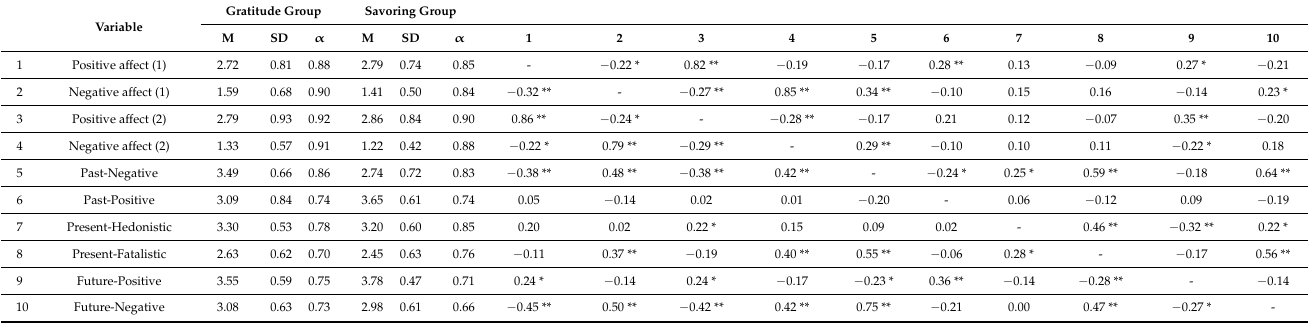
Table A1. Means, standard deviations, Cronbach’s alpha, and intercorrelations between variables in the gratitude group (lower part of table; N = 86) and the savoring group (upper part of the